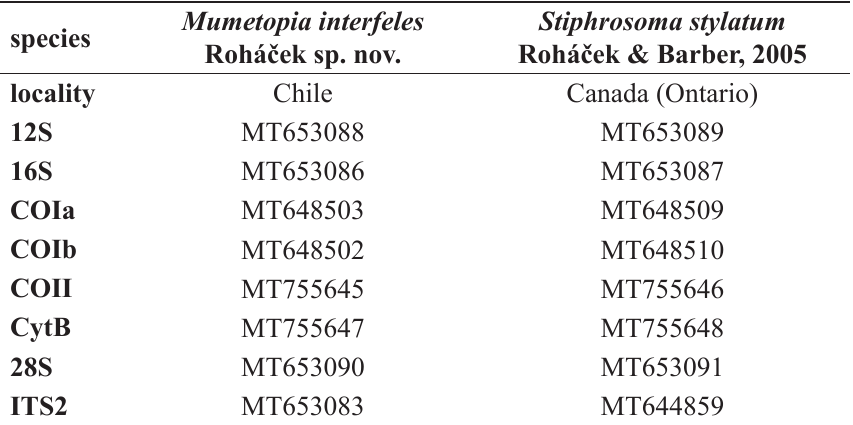
Table 1. Two species added to our dataset of Anthomyzidae used for the molecular analyses, with their GenBank accession